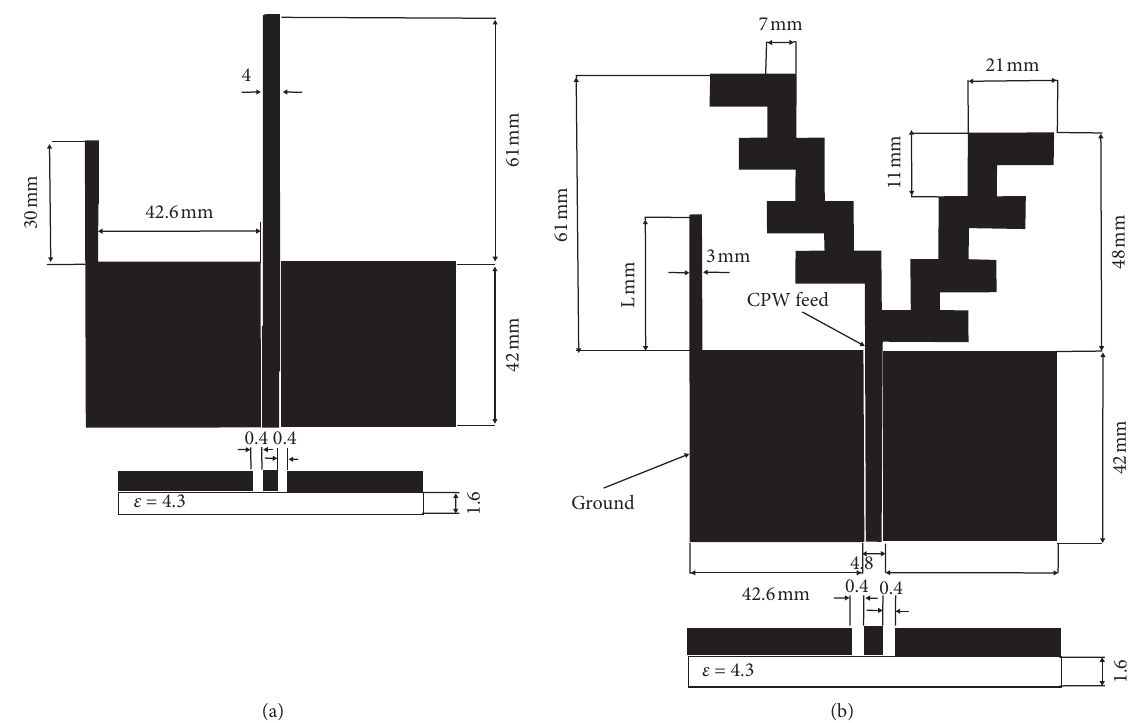
Figure 1: (a) Monopole CPW antenna without the fractal structure with the FR 4 substrate. (b) Monopole CPW proposed fractal antenna with the FR 4 substrate.